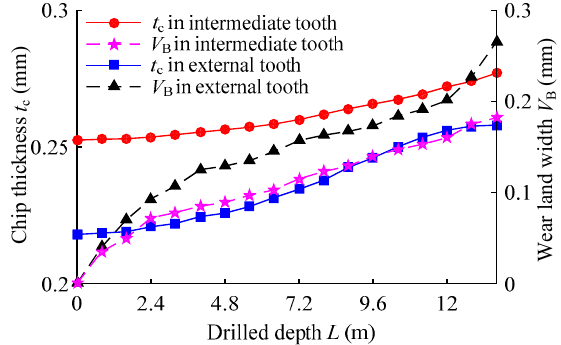
Figure 9. Effect of the drilling depth on tool wear and chip thickness.